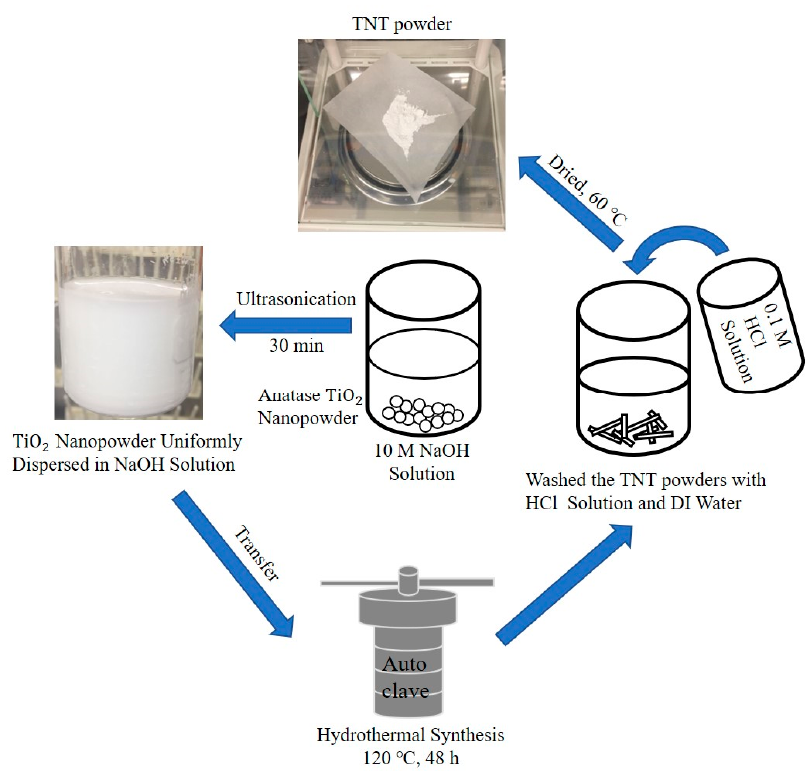
Figure 1. The titanium dioxide nanotube (TNT) hydrothermal synthesis process.